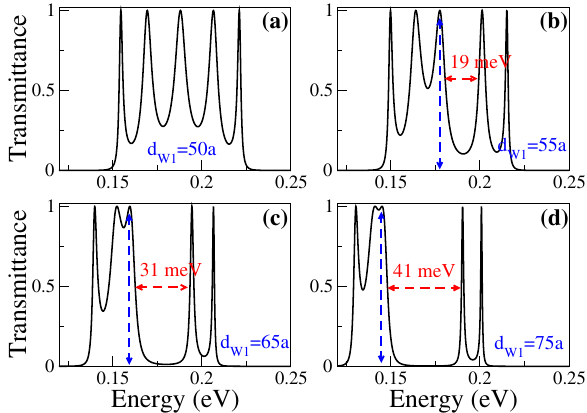
Figure 8. Main electron transmission band of BPGGSLs as a function of the energy for different d W 1 as indicated. The dashed-blue vertical arrows indicate the resonance associated to the transparent state. The other superlattice parameters are the same as in Fig. 6.